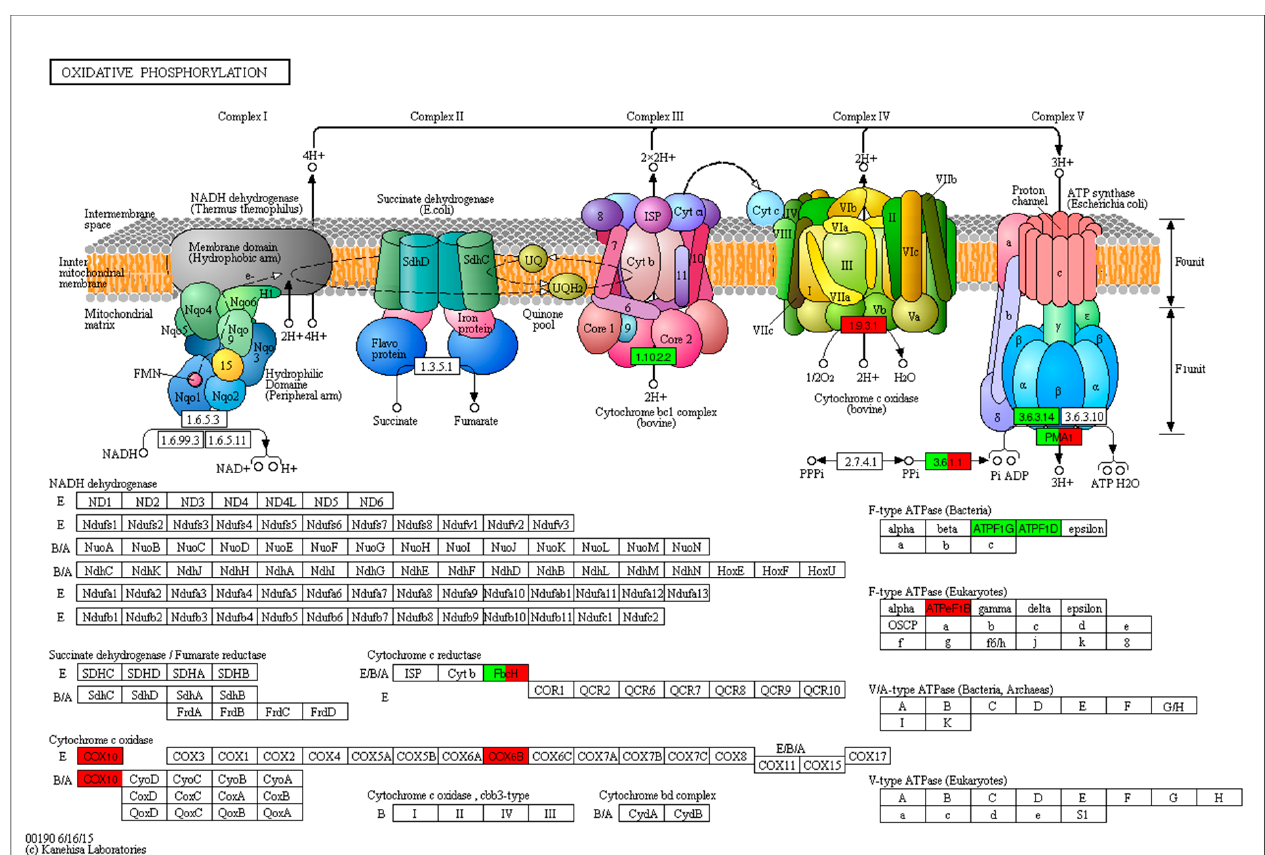
Figure 8. Oxidative phosphorylation-related genes as affected by UV-B stress. 2.10. Quantitative Real-Time PCR (qRT-PCR) Validation of DEGs from